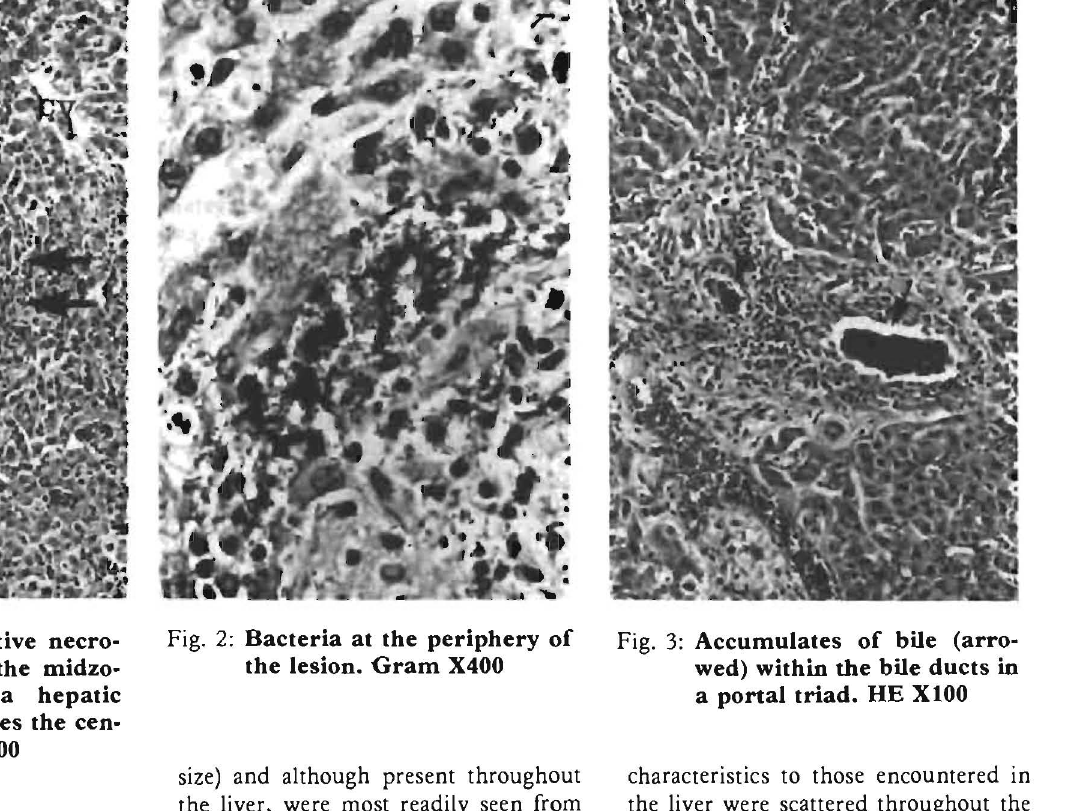
Fig. I: Focus of coagulative necro sis (arrowed) in the midzo nal region of a hepatic lobule. (CV denotes the cen tral vein). HE XIOO